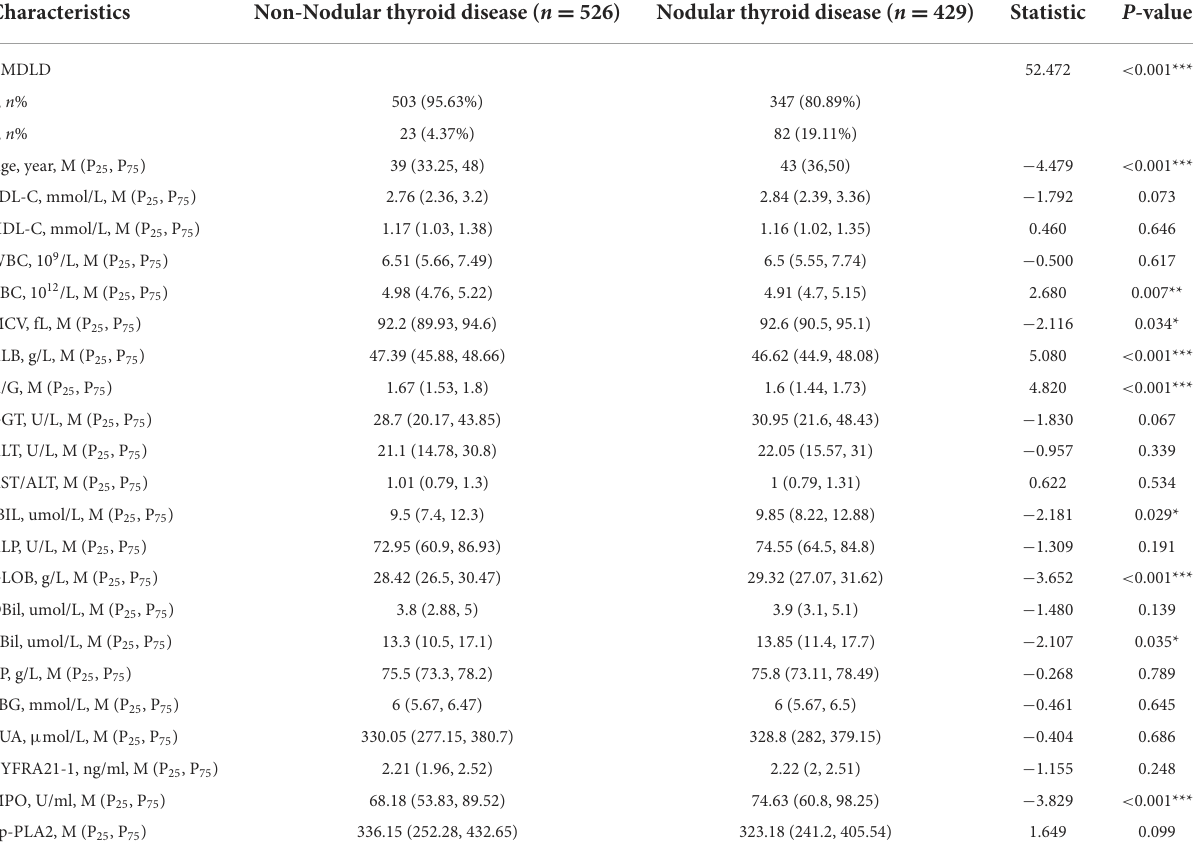
TABLE 1 Baseline clinical characteristics of two groups of coal miners.